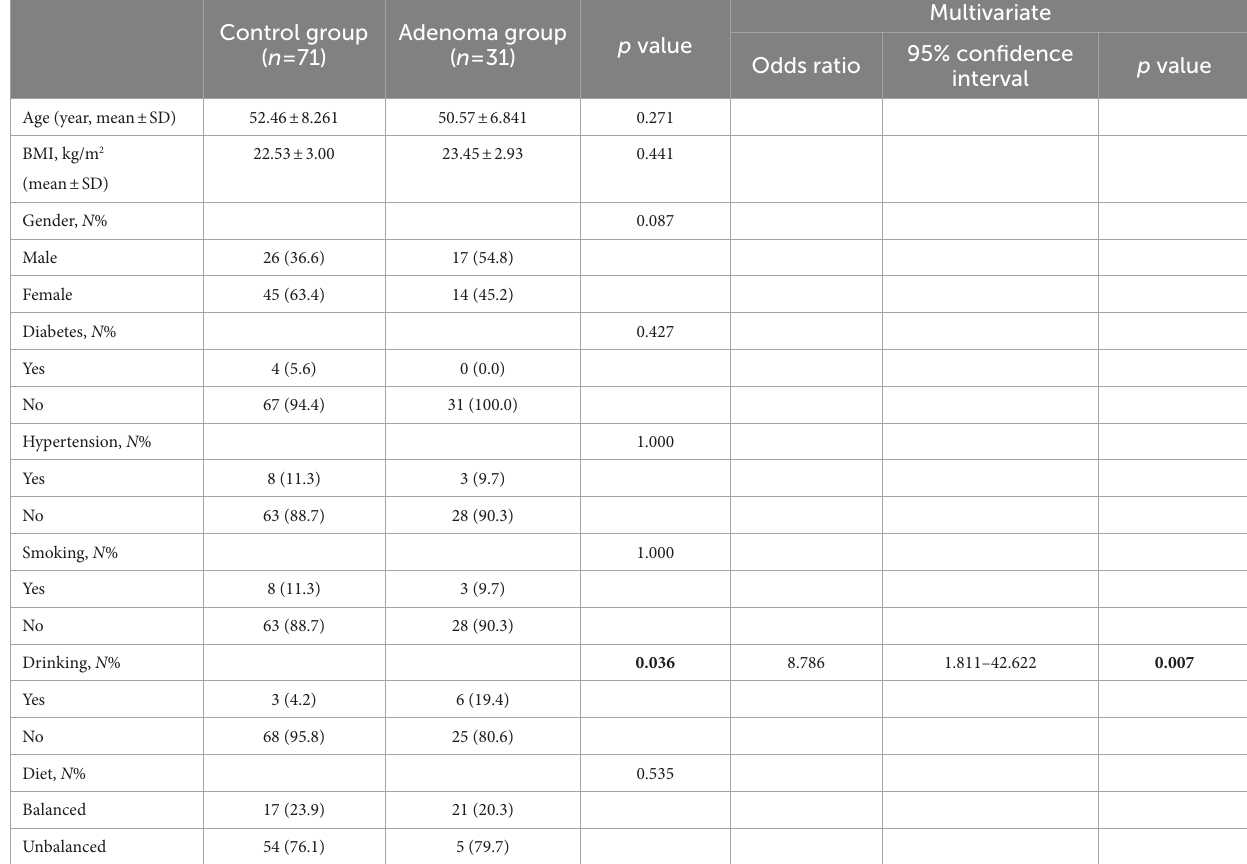
TABLE 2 Demographics and baseline characteristics of patients between control group and adenoma